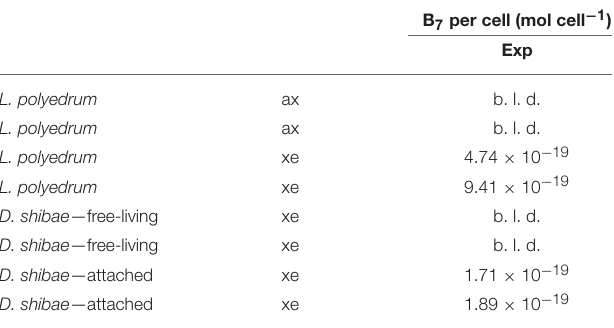
TABLE 3 | B 7 quotas expressed per cell (mol cell − 1 ) for axenic L. polyedrum and with D. shibae in